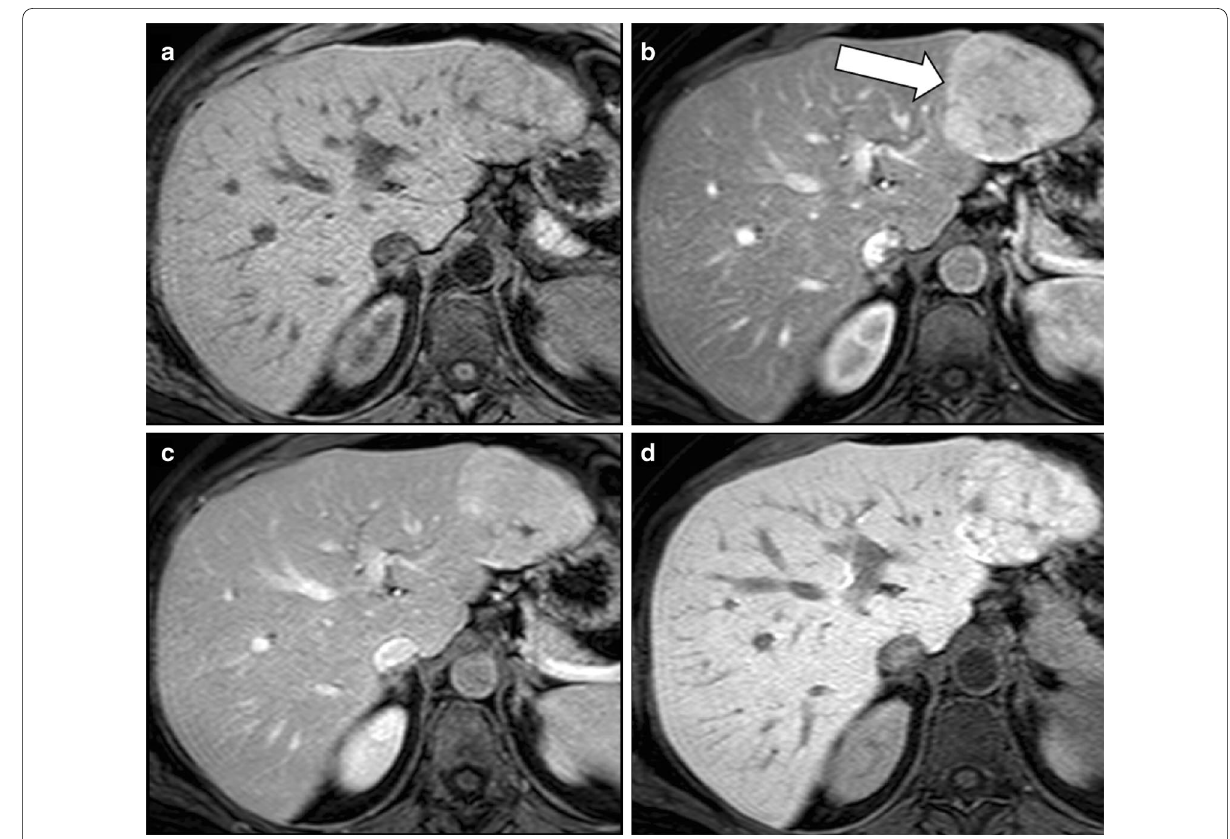
Fig. 2 A 46‑year‑old woman with focal nodular hyperplasia. Gadoxetate disodium‑enhanced MRI shows a focal nodular hyperplasia that is ( a ) nearly isointense to liver parenchyma in the precontrast T1‑weighted sequence, ( b ) with marked hyperenhancement (arrow) in the arterial phase, ( c ) mildly hyperintense in the portal venous phase and ( d ) hyperintense in the hepatobiliary phase